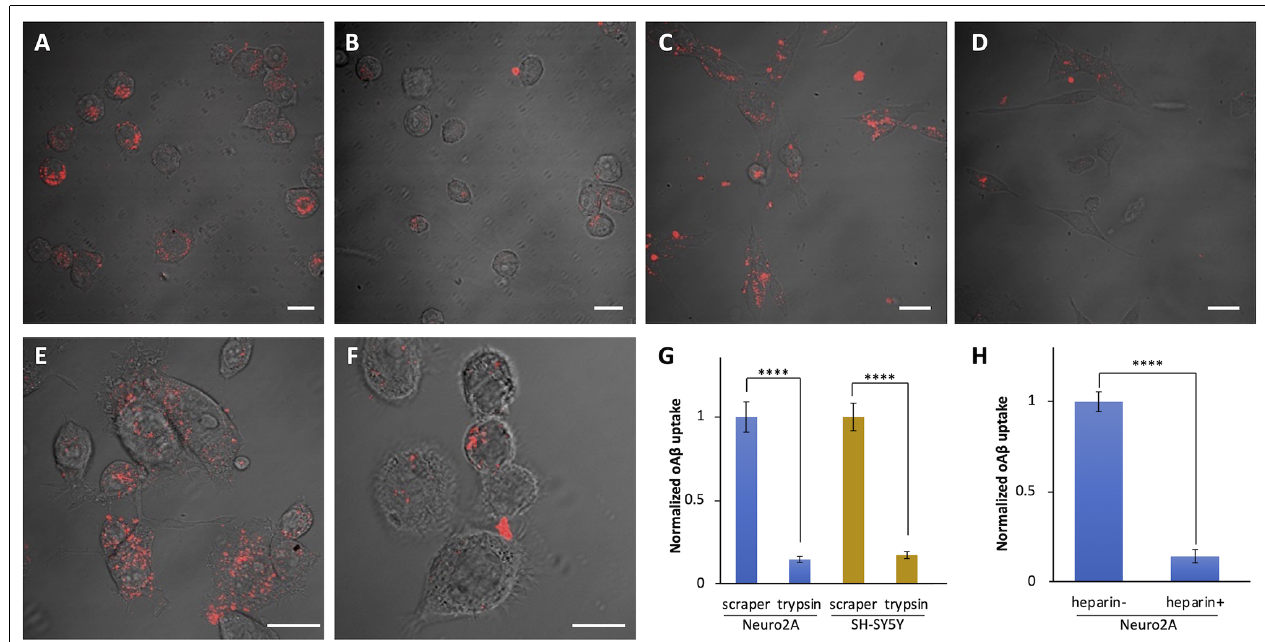
FIGURE 3 | Impaired uptake of oA β 42 by the treatment with heparin and trypsin. (A,B) Neuro2A cells were dissociated using a scraper (A) or by 8 min of treatment with 0.25% trypsin-EDTA (B) . After treatment with oA β 42 in 1.5 ml microcentrifuge tubes for 90 min, cells were washed and incubated for 24 h at 37 ◦ C in a medium free of oA β 42. The next day, cells were fixed and observed under a confocal microscope. SH-SY5Y cells were treated in the same manner using a scraper (C) or trypsin (D) . Neuro2A cells were cultured in the absence (E) or presence (F) of heparin (50 ng/ml) for 30 min; then, oA β 42 (5 µ M) was added for 90 min and observed under a confocal microscope. Scale bars = 10 µ m. (G,H) Fluorescent intensity of three independent experiments shows a marked reduction in the uptake of oA β 42 in the presence of trypsin and heparin. Data are presented as mean fluorescence normalized to scraper or heparin. Data are presented as mean ± SEM. Significance was established by Student’s t-test. ∗∗∗∗ p <